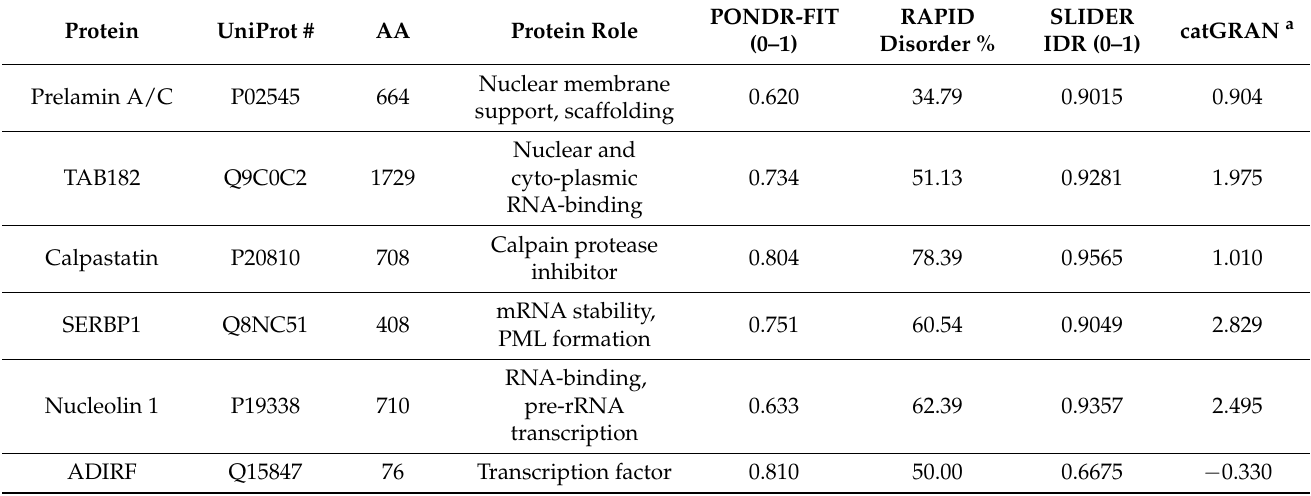
Table 2. Computational analysis for a subset of HaCaT keratinocyte-expressed thermostable proteins also found widely expressed in other cell types (see also Figure 6). Columns as in Table